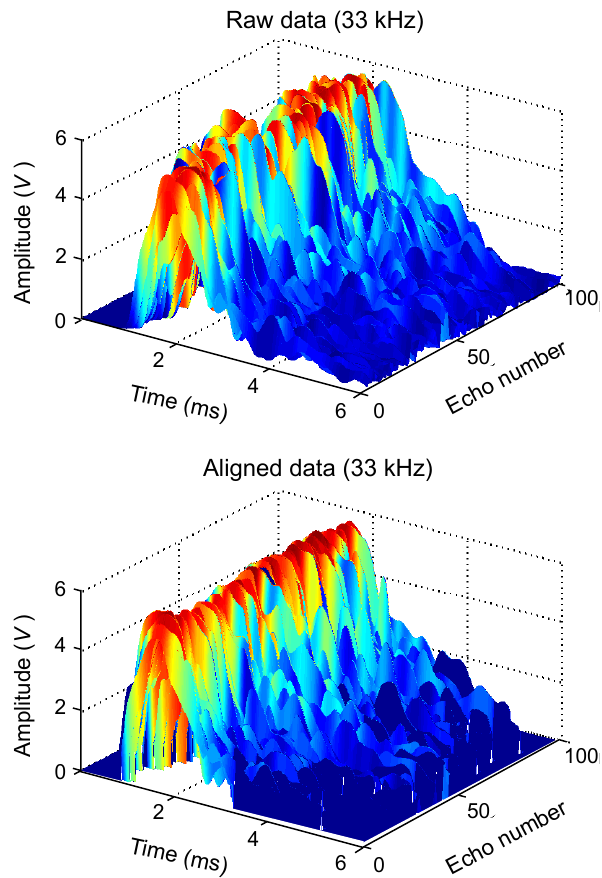
Fig. 2. Mesh plot illustrating the effect of echo alignment technique. The initial rise time and the time of peak amplitude of the raw backscatter envelope records are selected as the aligning features. The resulting aligned echo envelopes converted to the pressure val- ues were ensemble averaged to obtain a representative stable acous- tic signal (at each location) prior to multifractal